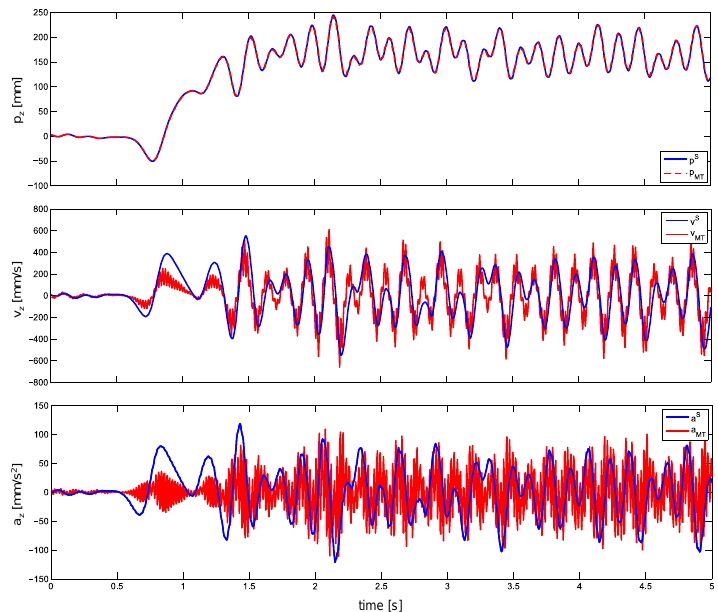
Figure 9. The position and acceleration of the instrumented box in z axis (direction with largest